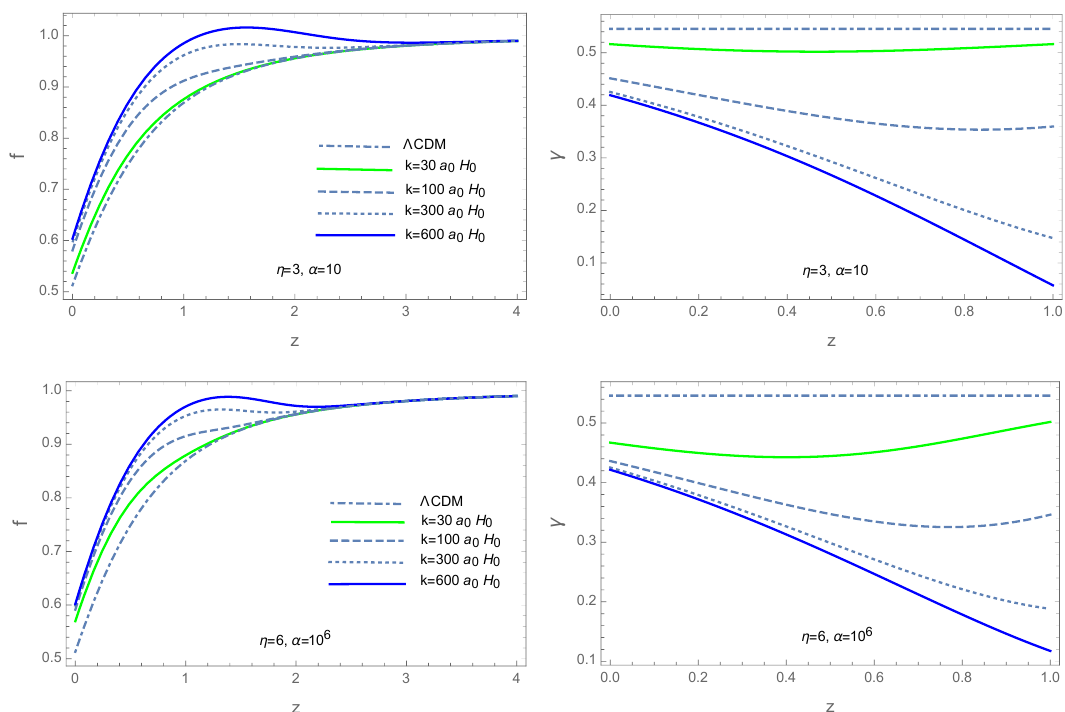
Figure 4 . The evolution of the growth rate f and the growth index γ in the model (3.5) with µ 2 = Ω m 0 H 2 , Ω m = 0 . 3 , Ω Λ = 0 . 7 . The upper figures correspond to η = 3 , α = 10 and those below 0 to η = 6 , α = 10 6 . The dispersion of γ is present for larger scales ( k = 30 a 0 H 0 and k = 100 a 0 H 0 ) at current epoch, indicating that the asymptotic regime k (cid:29) aM has not been reached. The transition redshift is larger for smaller η . For η = 3 , f and γ evolve very close to Λ CDM for the larger scale, k = 30 a 0 H 0